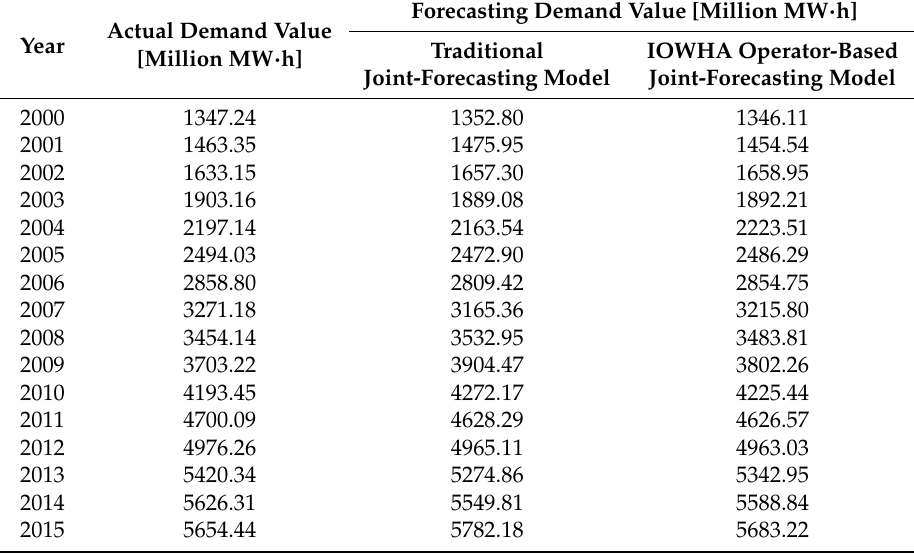
Table 4. Joint-forecasting modeling results.